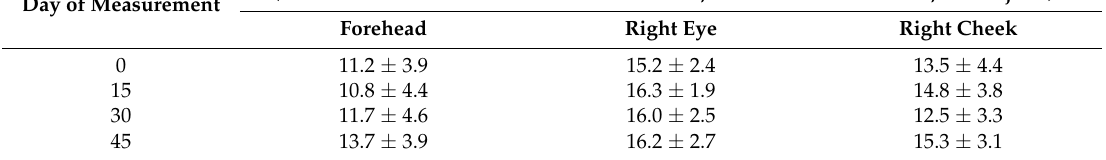
Table 4. Average results of the wrinkles evaluation on the forehead, the right eye, and the right cheek of volunteers. (Number of Wrinkles in Dimensionless Units, n = 3 for Each Skin Site; 24